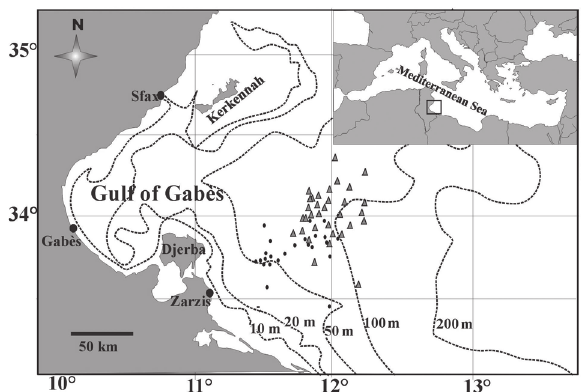
Fig . 1. – The Gulf of Gabès. locations of sets with turtles caught by Sll (triangles) and Bll